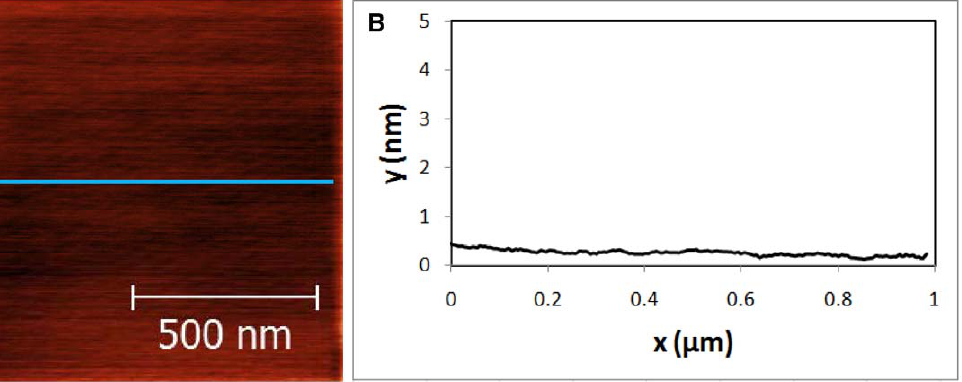
Figure 1. Topography of Cleaved Mica sample. (A) AFM image of cleaved mica surface. (B) Cross sectional image along the blue line shown in (A).